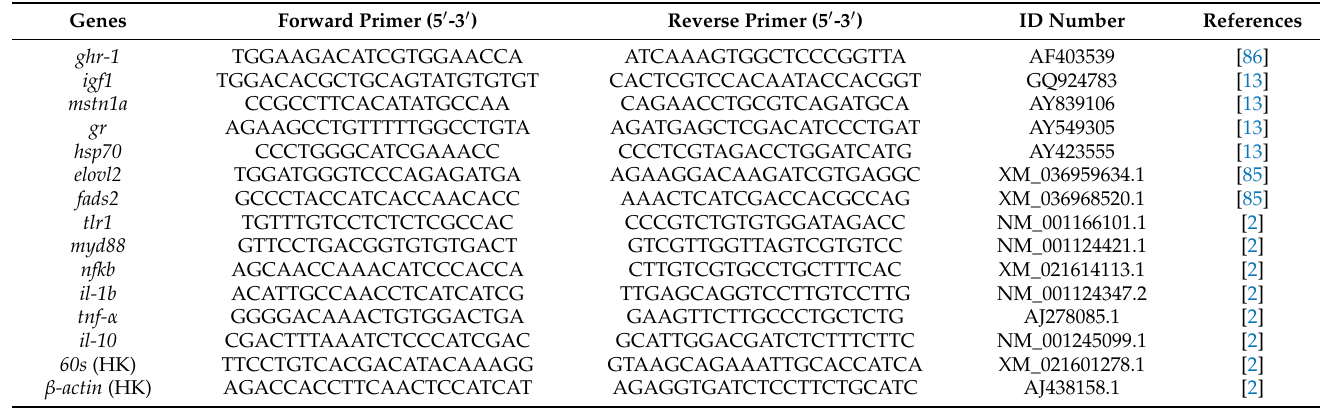
Table 2. Primers and identification numbers. (HK) = housekeeping